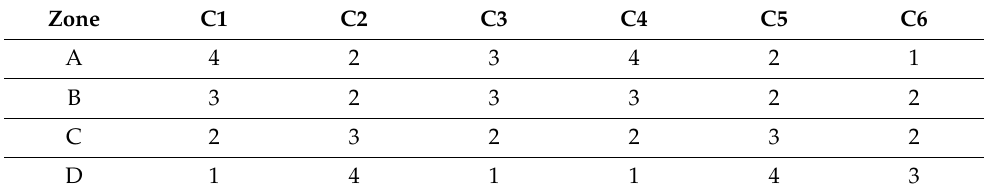
Table 5. Summary of complex social value with respect to the selected criteria. Zone C1